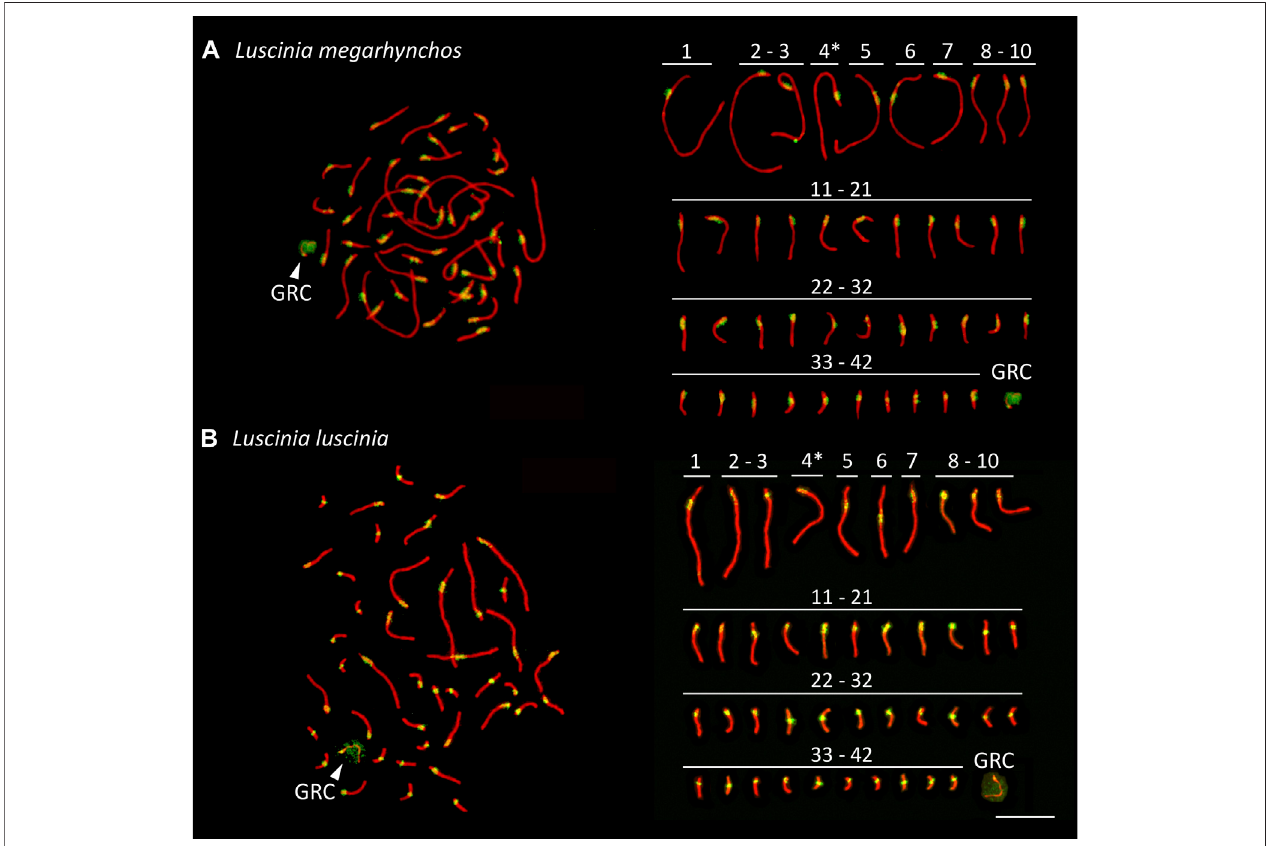
FIGURE 3 | Synaptonemal complex spreads made from testes of the common nightingale ( L. megarhynchos ) (A) and the thrush nightingale ( L. luscinia ) (B) , immunostained with antibodies against the lateral elements of the synaptonemal complex, SYCP3 (red) and against centromere proteins (green). The presumed Z chromosome bivalents are indicated with an asterisk and the germline restricted chromosome (GRC) with an arrowhead. Scale bar (cid:1) 10